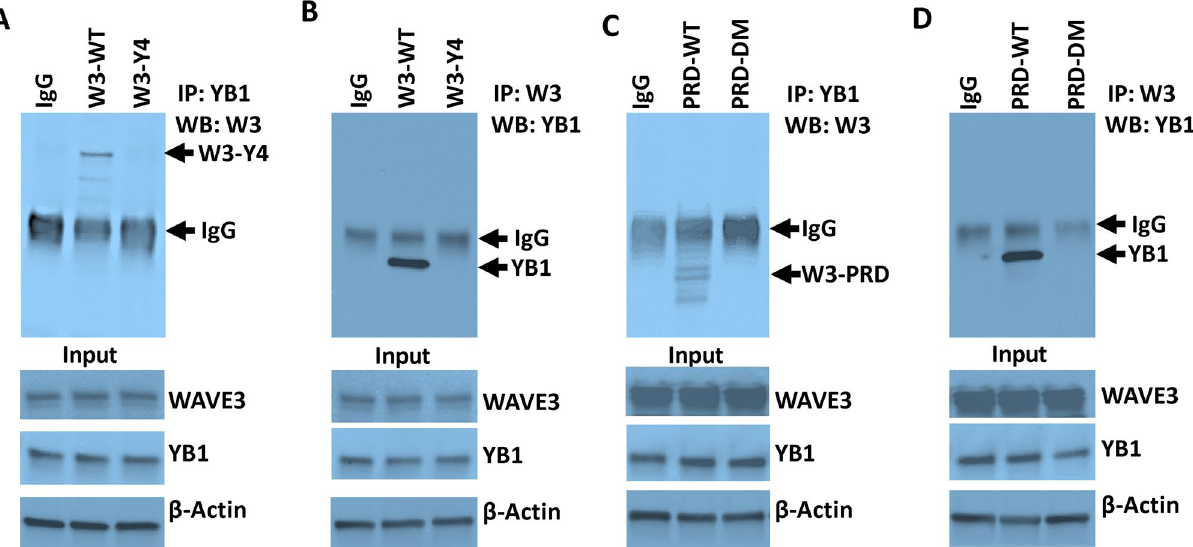
Figure 5. Phosphorylation of the WAVE3 PRD domain is required for the interaction between WAVE3 and YB1. ( A , B ) Protein lysates from WAVE3-deficient MDA-MB-231 cells expressing either wild-type WAVE3 (W3-WT) or phospho-mutant WAVE3 where all 4 tyrosine residues were mutated to phenylalanine (W3-Y4) were immunoprecipitated with ( A ) anti-YB1 antibody and subjected to immunoblotting with anti-WAVE3 or ( B ) anti-WAVE3 antibody and subjected to immunoblotting with anti-YB1 to detect phosphorylated W3-Y4 or YB1 (C and D) Protein lysates from WAVE3-deficient MDA-MB-231 cells expressing either wild-type PRD (PRD-WT) or phospho-mutant PRD (PRD-DM) were immunoprecipitated with ( C ) anti-YB1 antibody and subjected to immunoblotting with anti-WAVE3 or ( D ) anti-WAVE3 antibody and subjected to immunoblotting with anti-YB1 to detect phosphorylated W3-PRD or YB1. Cell lysates were sequentially immunoblotted with either anti-WAVE3 or anti-YB1 antibodies to show the presence of equal amounts of the corresponding proteins in the cell